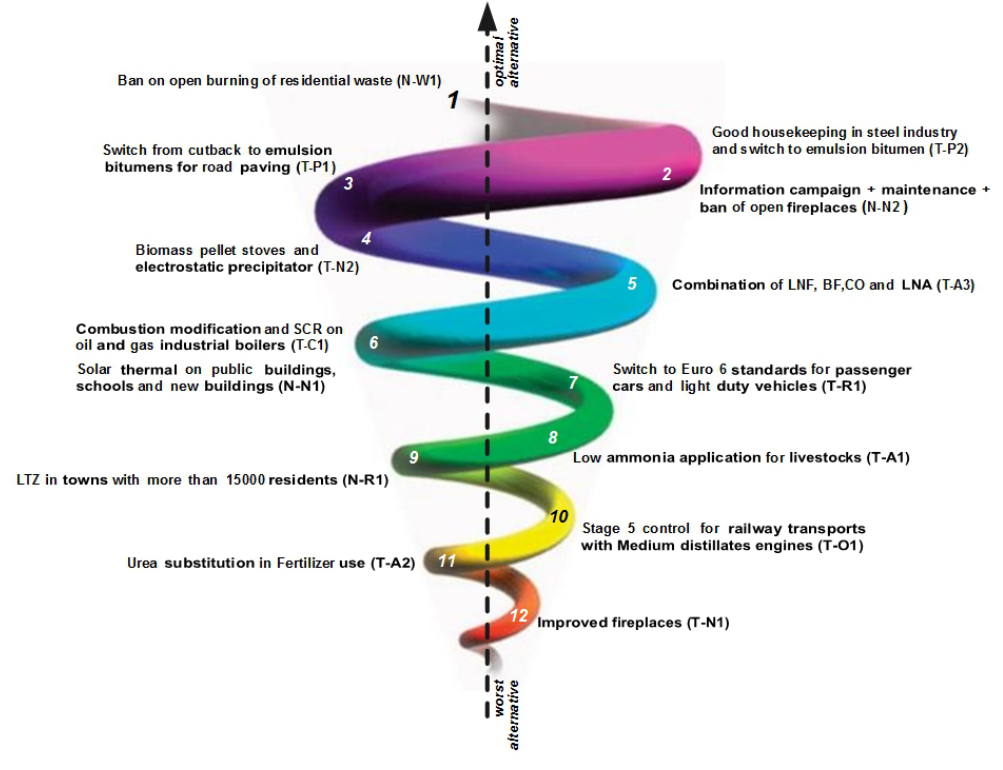
Figure 6. Final measure ranking as resulting from the application of Step